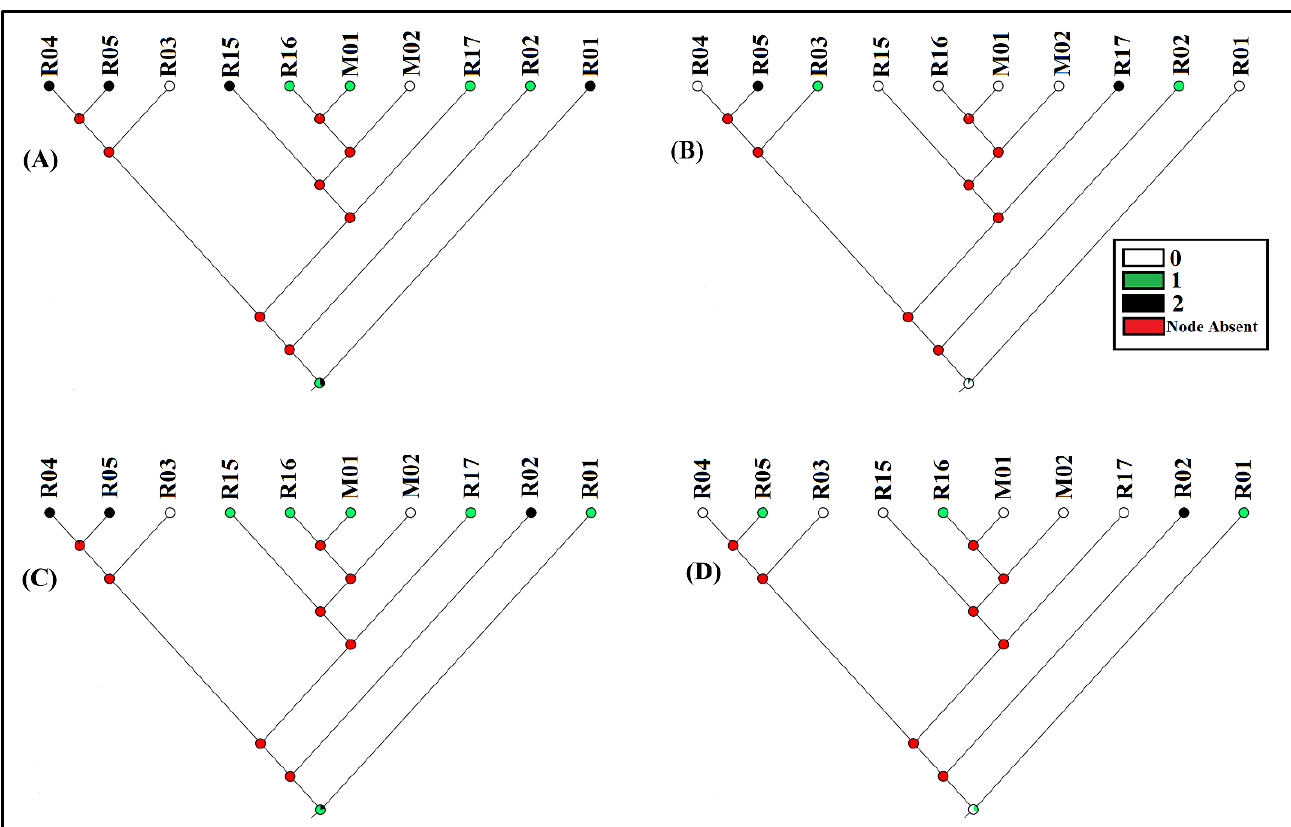
Figure 3. Tree of morphological features of Prunus mume accessions based on the maximum likelihood approach using Mesquite via mapping of encoded characters. Trees of selected morphological characters generated using modular Mesquite software; ( A ) flower diameter; ( B ) petal number; ( C ) pistil length (mm); ( D ) anther number.